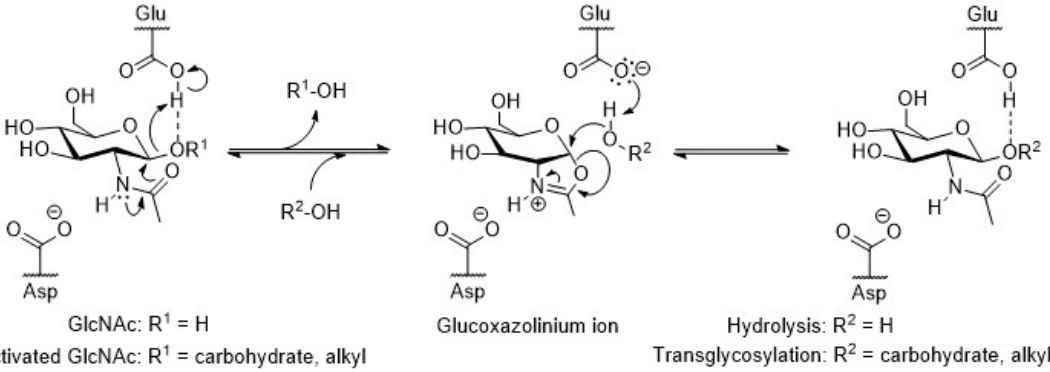
Figure 2. Proposed substrate-assisted mechanism of GH20 β - N -acetylhexosaminidases [29]. Indication of the intermediate as a Glc-oxazolinium ion is based on recent computational studies on a GH84 O-GlcNAcase probably utilizing the same mechanism [32].